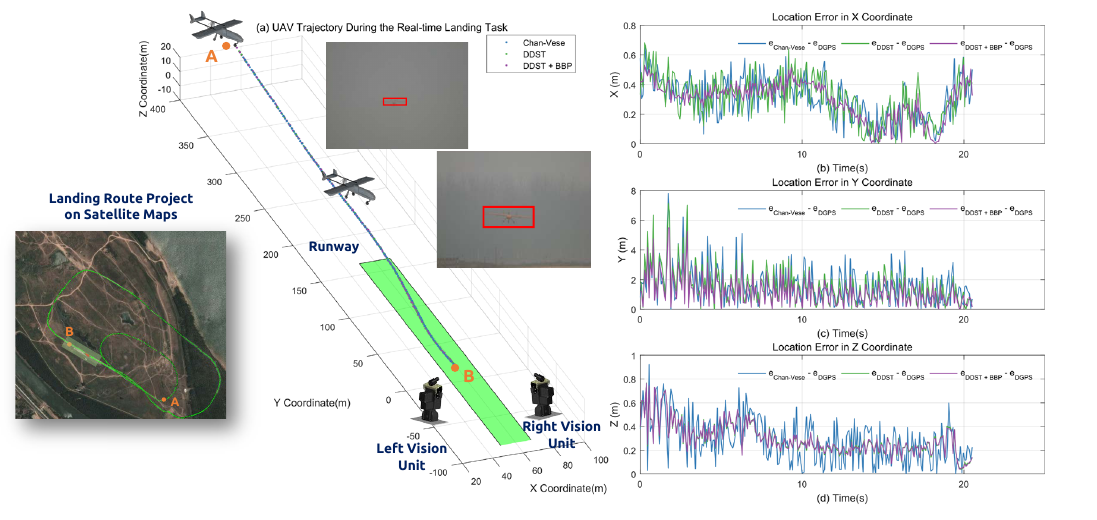
Figure 12. Final approach of the fixed-wing